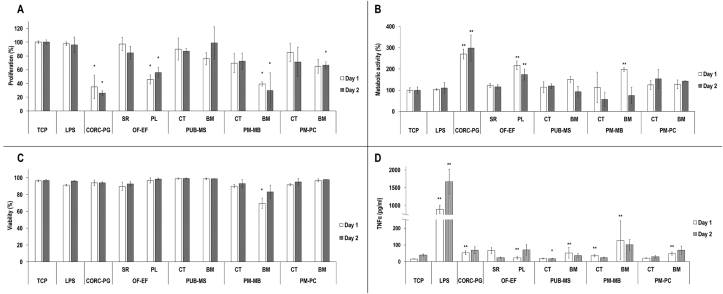
THP-1 response in vitro assessment revealed the lowest (∗p<0.05) proliferation on CORC-PG, PL side of OF-EF, and BM side of PM-MB at both time points (A). The highest (∗∗p<0.05) THP-1 metabolic activity was observed for the CORC-PG and the PL side of OF-EF at both time points (B). All groups exhibited similar (p>0.05) THP-1 viability at day 2 (C). Pro-inflammatory cytokine TNF-α analysis showed the highest (∗∗p<0.01) production by THP-1 cells in the LPS group (D). Among the test groups, higher TNF-α production (∗∗p<0.05) was observed on CORC-PG, PL side of OF-EF, and BM sides of PUB-PM, PM-MB, and PM-PC at day 1, although far from LPS levels (D). Data expressed as average ± standard deviation (n = 3). Samples were compared to the monocytes cultured on TCP with normal medium at a given time point.